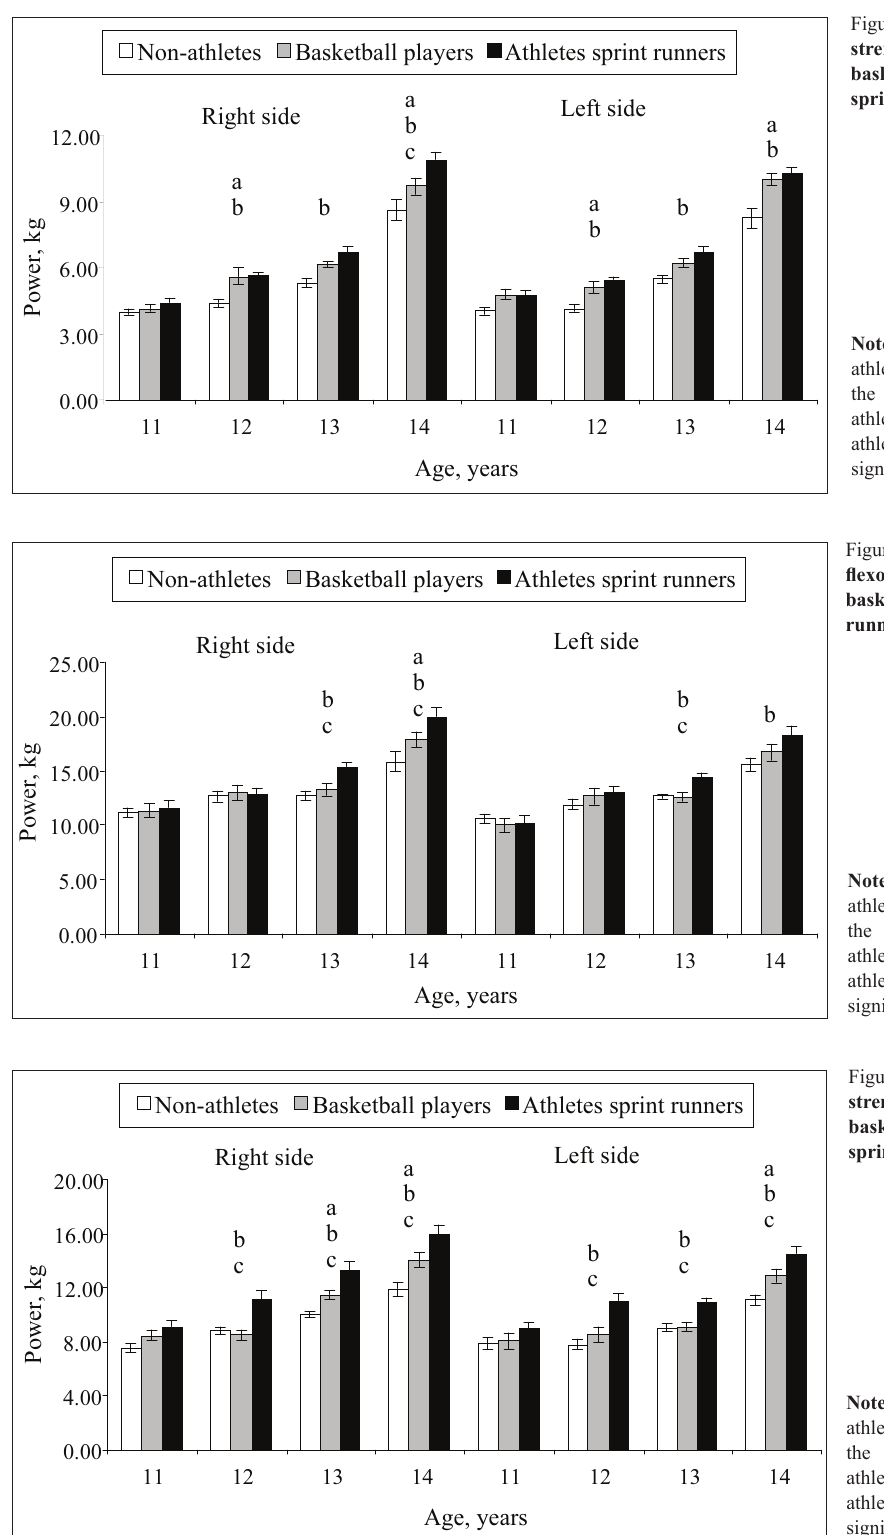
Figure 1. The results of arm levators strength in the non‑athletes, sport basketball players and athletes sprint runners